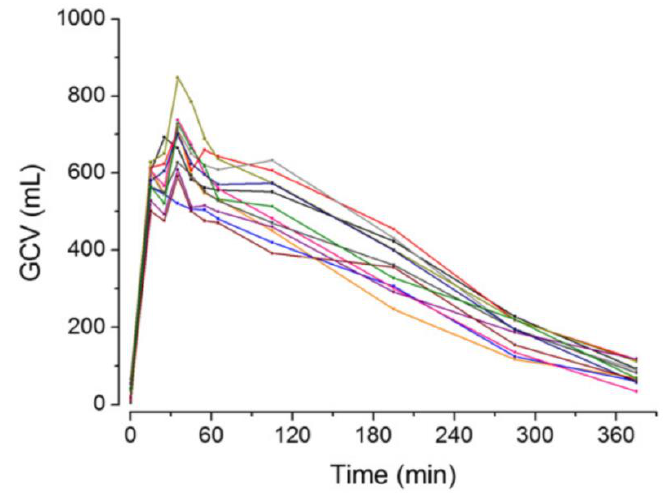
Figure 1. Gastric content volume (GCV) changes after administration of 240 mL of water in fasted state. Figure 1. Gastric volume changes after administration of 240 mL of water in fasted state. Reprinted Reprinted from Reference [27] with permission from the American Chemical Society. from Reference [27] with permission from the American Chemical Society.